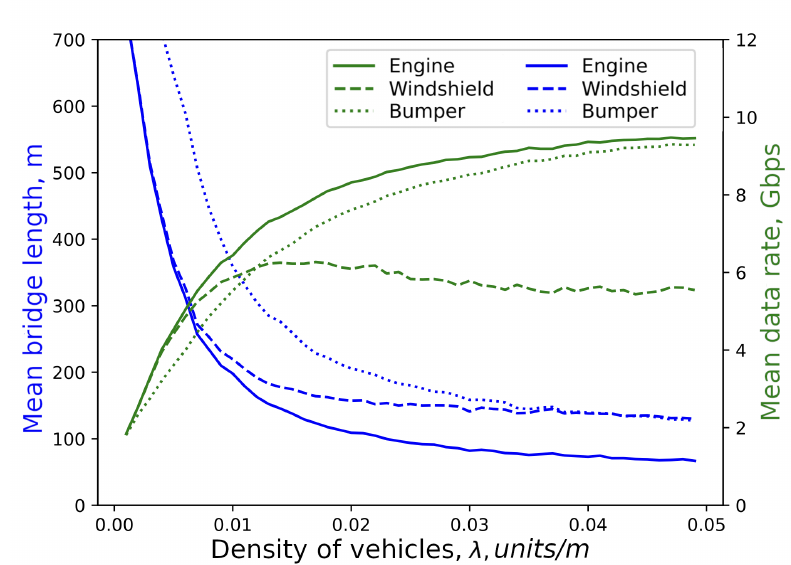
Figure 4. Trade-off between the bridge length and data